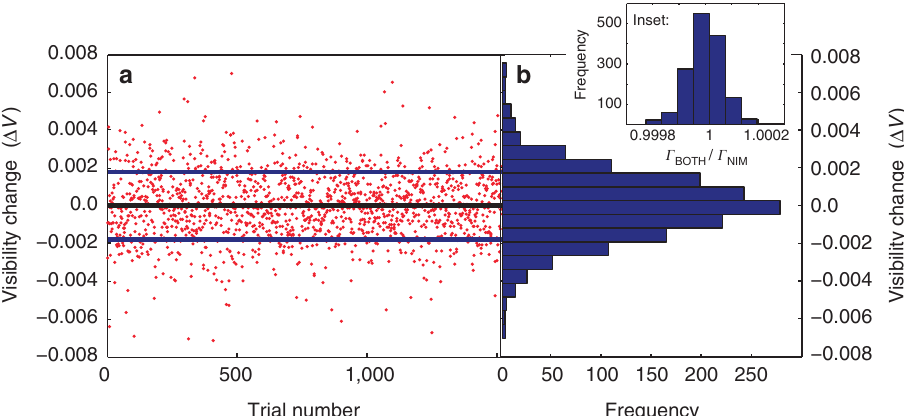
Figure 4 | Results for repeated runs of the experiment. ( a ) Each point corresponds to one run of the experiment, consisting of turning the liquid crystal off and measuring the visibility of the Mach–Zehnder interferometer, followed by turning the liquid crystal on and remeasuring the visibility. The difference between these two visibilities for each run is plotted here for data from each of the two ports of the Mach–Zehnder interferometer. A total of 761 experimental runs were made, resulting in 1,522 values of D V . The black line marks the mean of all of the points, and the blue lines the standard deviation. ( b ) A histogram of data plotted in a . The error bars (from fitting to extract the visibility) on the individual points are not shown for clarity. Inset: A histogram of the values of G BOTH , computed from the data in a . The mean value of this distribution is used to compute a phase difference between photons seeing the G NIM liquid–crystal phase retarder before or after the metamaterial. A mean value of this distribution that is a 1 would indicate some form of